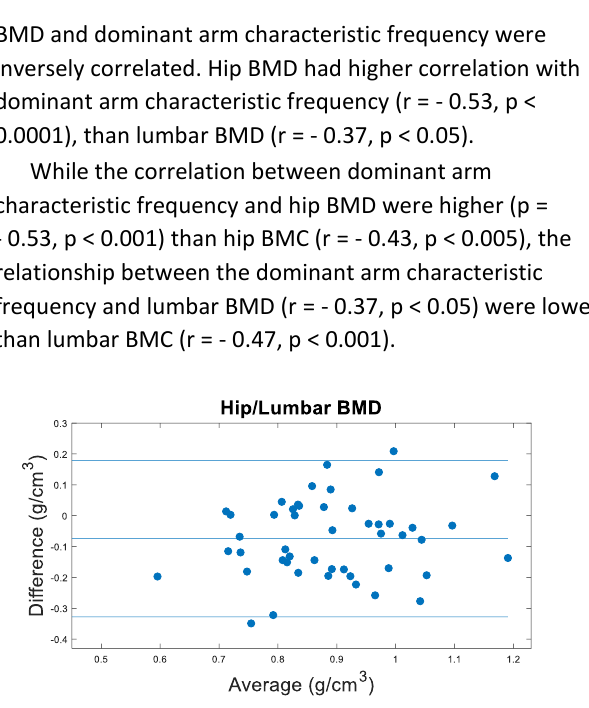
Figure 2. Comparison of Hip and Lumbar Spine DXA BMD. Results by Bland Altman